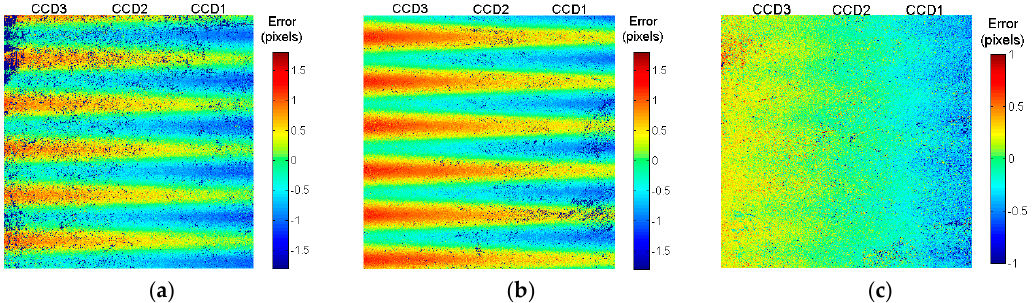
Table 5. Statistical results of the fitting residuals (unit: pixel).